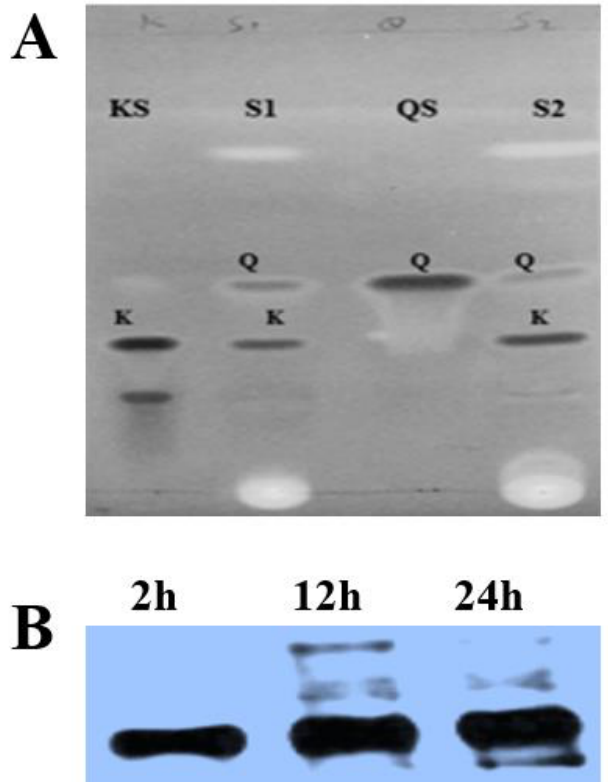
Figure 2. TLC analysis and functional expression of OsF3H gene in yeast. ( A ) TLC detection of kaempferol and quercetin under 366 nm UV light. Two samples were analyzed after fractionation through silica column, indicated as S1 and S2, mean sample one and two, respectively. At the same time, standards were also run for comparison, represented by KS as kaempferol standard and QS as quercetin standard, while K represents kaempferol and Q represents quercetin bands. ( B ) immunoblot analysis of yeast recombinant protein of the OsF3H gene. The same amounts of transformed strain (each time point) and empty strain protein were prepared and subjected to immunoblot analysis. SDS-PAGE analysis did not detect the target protein in the empty strain and it was not further analyzed for immunoblotting analysis. The time points of 2, 12 and 24 hrs, respectively, represent protein extracted from yeast strain feeding on substrate after each time